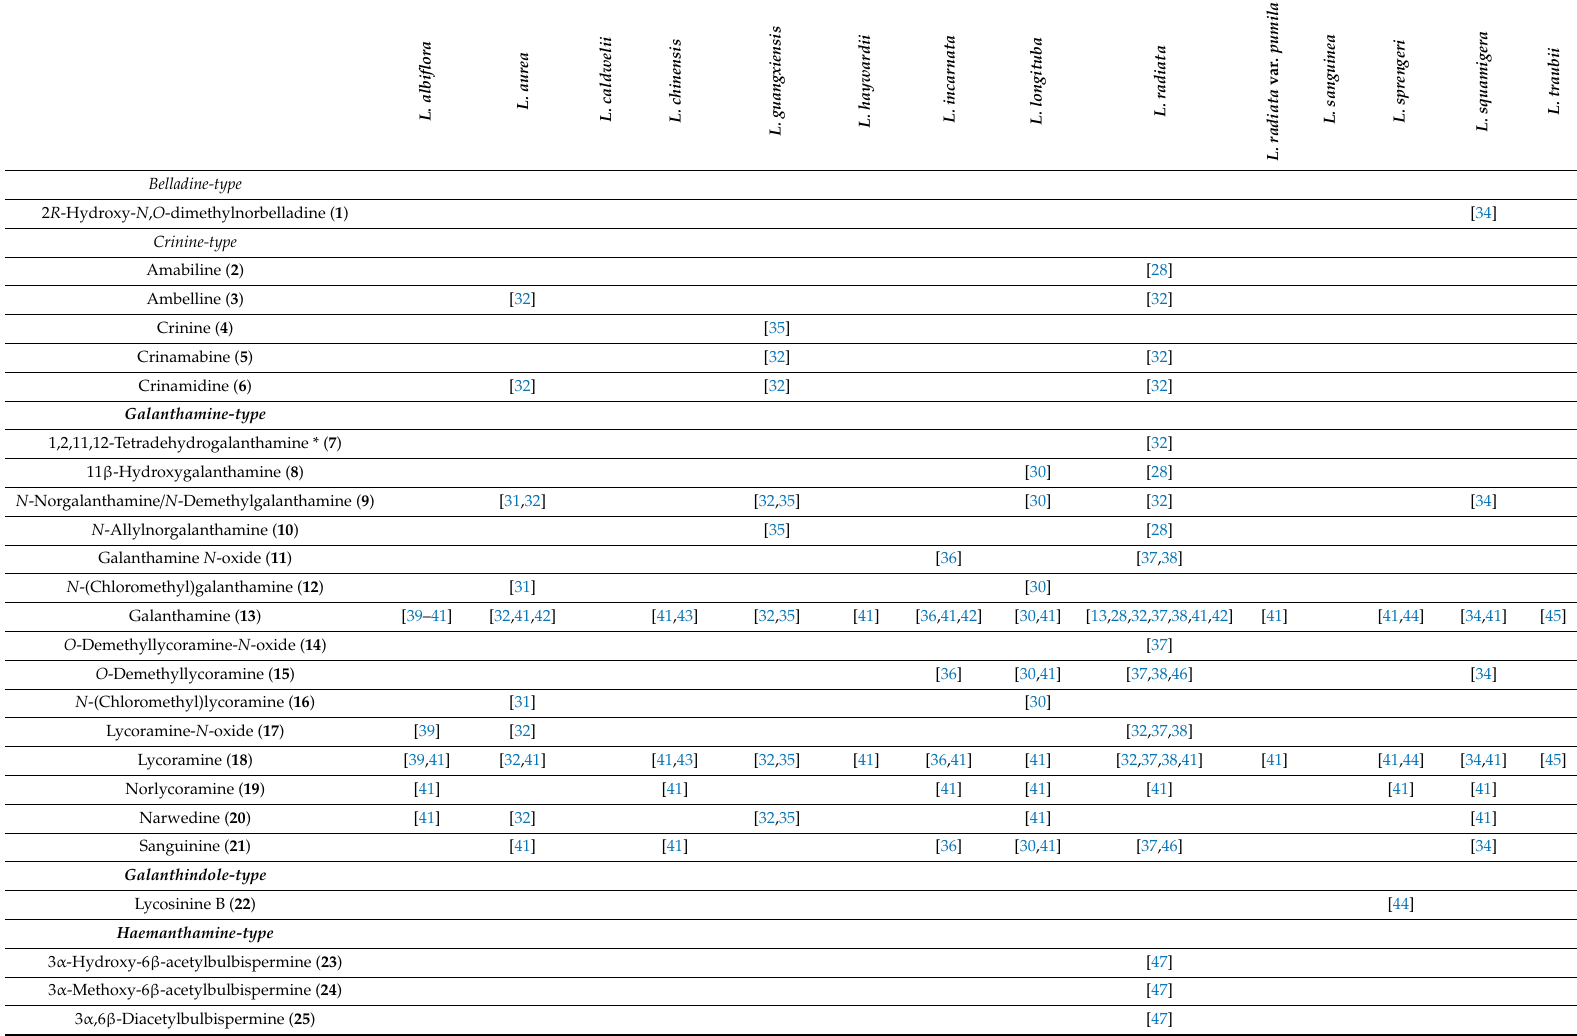
Table 1. Alkaloids reported in the genus Lycoris